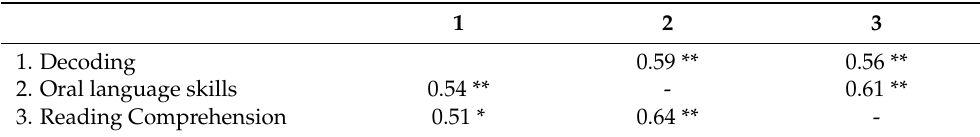
Table 3. Correlations between bilingual children’s performance on English decoding and oral language skills in Time 1 and reading comprehension in Time 2, with zero order correlations above the diagonal, and correlations between age-controlled variables below the diagonal.